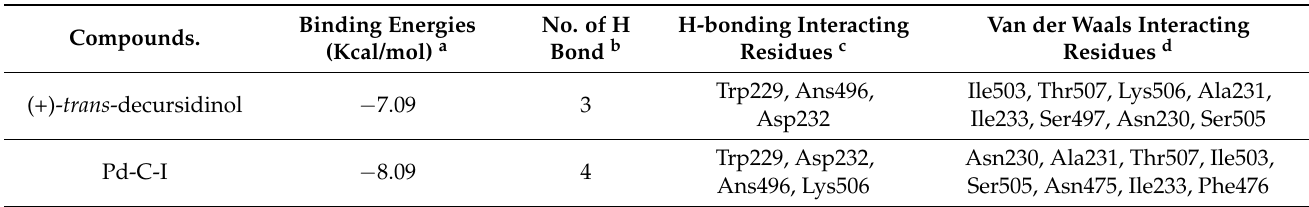
Table 3. Binding sites of dihydroxanthyletin-type coumarins in α -glucosidase using the Autodock 4.2 molecular docking program.